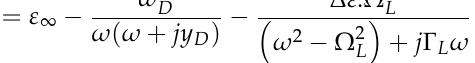
Figure 3. ( a ) X-polarized core mode ( b ) Y- polarized core mode ( c ) SPP